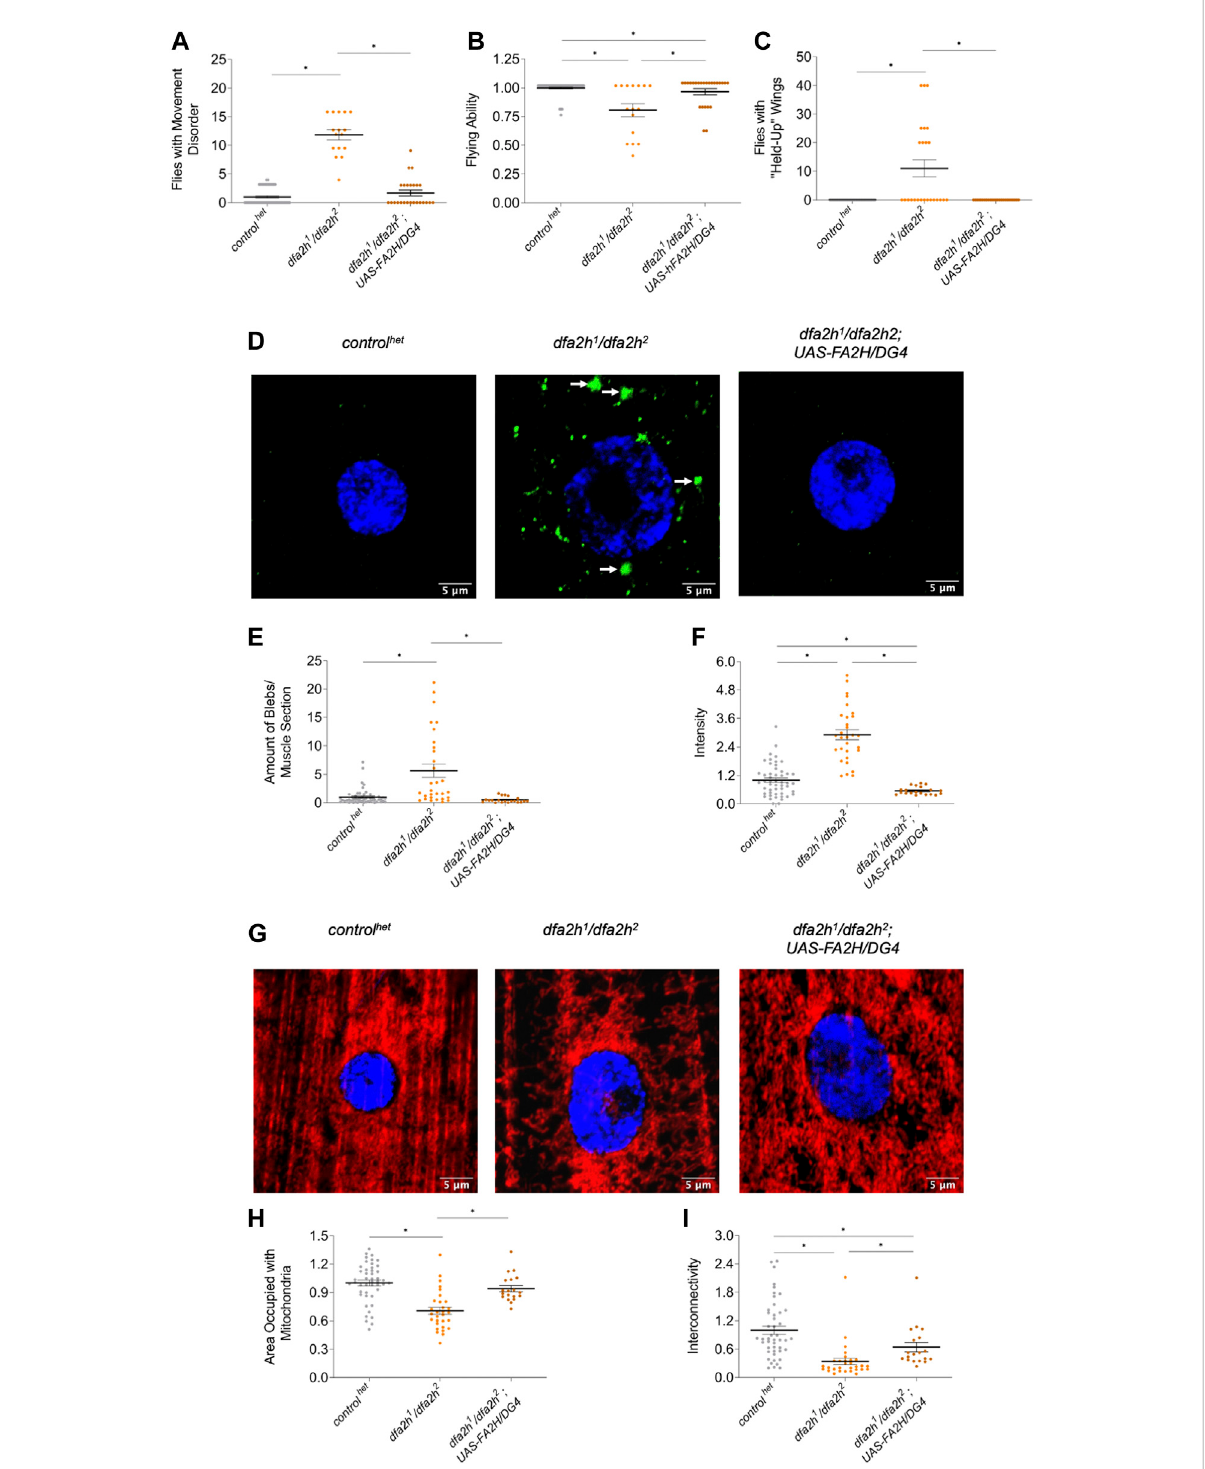
FIGURE 4 Overexpression of human FA2H rescues the loss of dfa2h phenotypes. The rescue line shows (A) reduced number of fl ies with movement defects, (B) increased fl ightability,and (C) lowernumberof fl ieswith “ held-up ” wingscomparedtothe dfa2h 1 /dfa2h 2 mutant.Fortheseexperiments, groupsoffourto fi ve fl ieswereformed(n fl ightandmovement =25 – 46;n wing =25 – 46). (D) Immunostainingoflarvalmusclesectionswiththeautophagy marker dLC3 revealed (E) reduced accumulations and (F) intensity in rescue fl ies compared to compound heterozygous mutants ( n = 20 – 50).